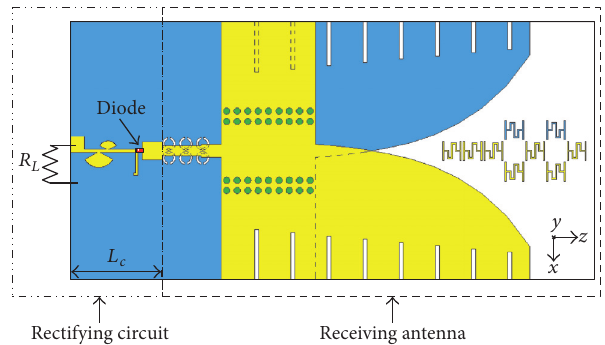
Figure 10: Structure of the proposed